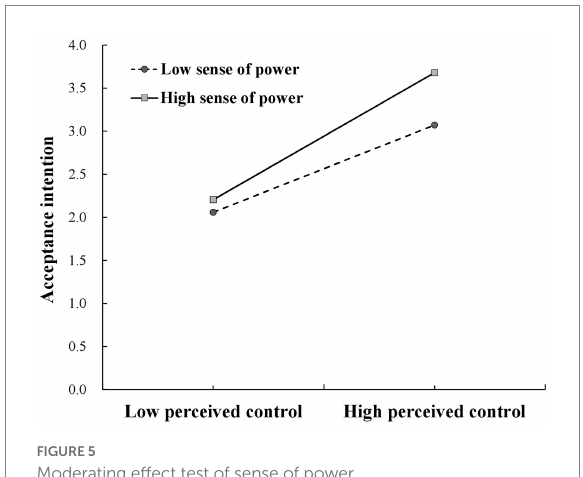
FIGURE 5 Moderating effect test of sense of